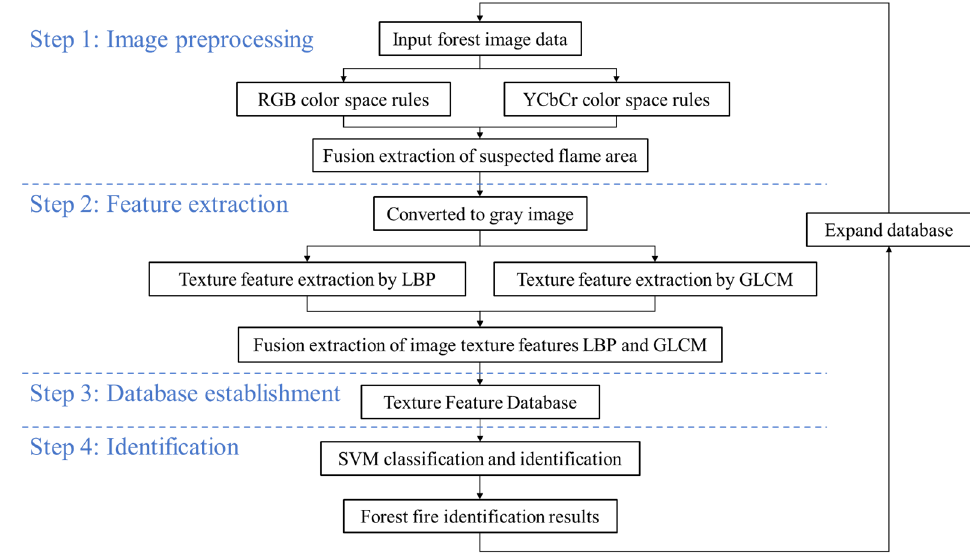
Figure 1. Forest Fire Identification Process.